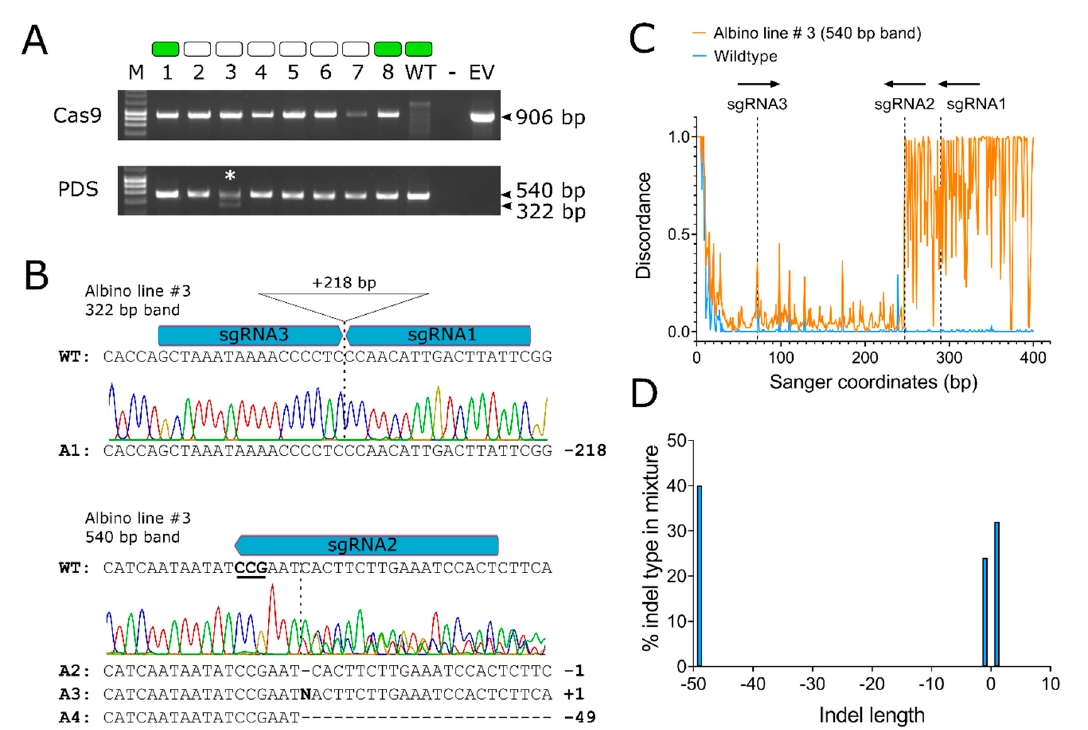
Figure 3. Detecting the presence of the transgene and CRISPR/Cas9-induced indels, by PCR and Sanger sequencing. ( A ) T-DNA integration was confirmed by PCR amplification of a 906 bp fragment of the Streptococcus pyogenes Cas9 gene (upper gel). Edits were detected by PCR amplification of a 540 bp fragment of the Hieracium PDS gene (lower gel). Phenotypes of the plants that were examined in this assay are depicted above the gel as green (wildtype) or white (albino) boxes. The D36 wildtype control (WT), no template control (–) and pDE-Cas9 empty vector positive control (EV) are also shown. ( B ) Sanger sequencing chromatograms of the gel purified 340-bp band (upper) and 540-bp band (lower) shown in lane 3 (asterisk). The position of the sgRNAs within the wildtype (WT) sequence is shown above the chromatograms, PAM is underlined, and the predicted cut sites are shown as vertical dashed lines. Alleles inferred in the edited sequences are shown below the chromatograms; ( C ) visualization of the discordance between Sanger traces of the ~540-bp band derived from the wild type (blue) and albino line # 3 (orange), determined using ICE analysis. The expected cut sites for each sgRNA are shown as vertical dotted lines; ( D ) inferred alleles and their frequencies, detected within the ~540-bp band of albino line 3, by Synthego ICE analysis. 3.3. Amplicon Deep Sequencing Reveals a Wide Range of CRISPR/Cas9-Induced Indels in Hieracium Primary Transformants To examine in more detail the type and frequency of CRISPR/Cas9-induced edits in the HPDS gene, amplicon deep sequencing was performed on 18 independent T0 transformants (6 green, 5 chimeric and 7 albino). The 7 albino lines included those shown in Table 1 and an additional three plants from leaf-disk transformations where phenotypic frequencies were not scored. Edits were identified as variations in the amplicon sequences near the predicted cleavage sites from those of an untransformed D36 control. Analysis of the combined mutations across two amplicons in 18 transgenic lines revealed differing frequencies of insertions (55.9%), deletions (38.2%), substitutions (4.4%) and combined mutations (1.5%) (i.e., >1 mutation type in an allele) (Figure 4A, Table S2). Single base mutations occurred 60.3% of the time (Figure 4B, Table S2). Adenine was the most frequently inserted single base, accounting for more than half of the 1 base insertions (55.3%), while single guanine insertions were not observed in our selection of transgenics (Figure 4C, Table S2). These single base insertion frequencies are similar to those reported in Brassica napus [39]. Promisingly, 6% of the editing